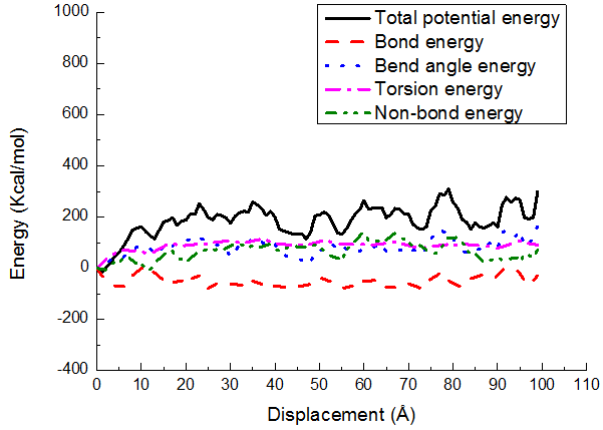
Figure 13. Potential energy-displacement curves for the PE(150-40)/S interface in the shear case. Please change the format like -40 to − 400(use minus sign)